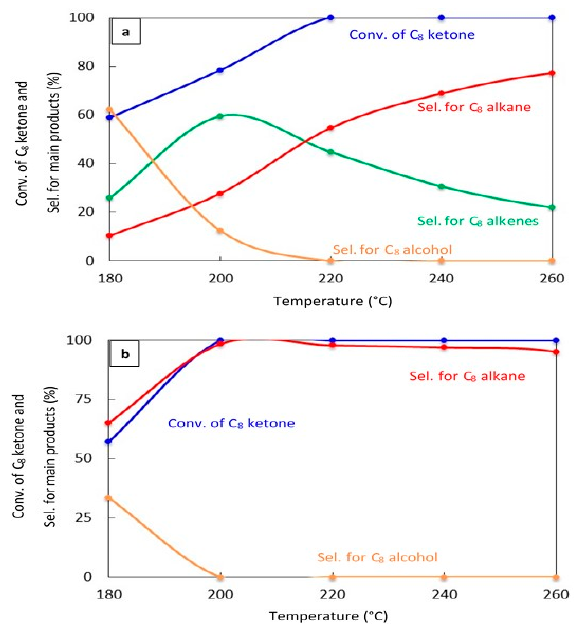
Figure 4. Catalytic results for the conversion of the C 8 ketone to several products with different temperatures using 0.5 g of catalyst: ( a ) (20% Cu-Al 2 O 3 ), ( b ) (1% Pt-Al 2 O 3 ). Reaction conditions: reaction temperatures ranged from 180 °C to 260 °C; the total flow rate of H 2 and N 2 , 85 mL/min; the flow rate of H 2 and N 2 , 68.5 and 16.5 mL/min, respectively; the flow rate of C 8 ketone, 1 mL/h; and the molar ratio of H 2 /C 8 ketone, 25. All catalysts were calcined for 4 h.